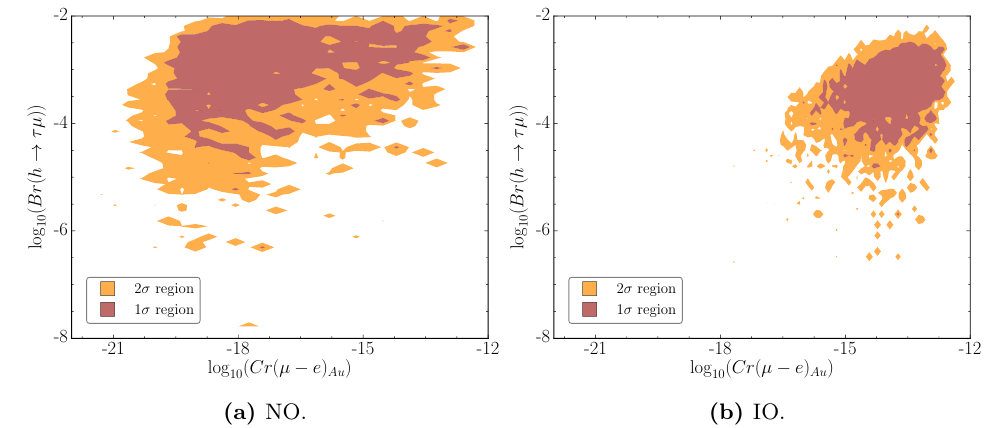
Figure 6. Allowed regions of (cid:22)e conversion and the branching ratio Br( h (b)